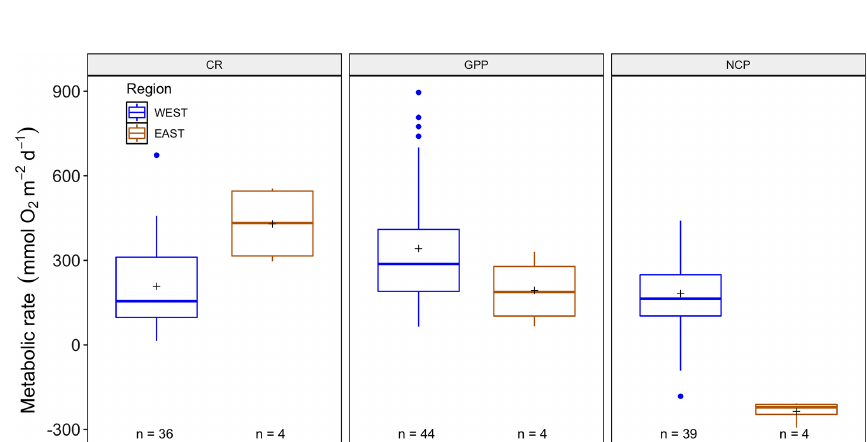
Figure 3. Averaged GPP, NCP and CR (mmolO 2 m − 2 d − 1 ) values for eastern (blue) and western (orange) Mediterranean basins calculated from measurements of multiparametric sensors. Upper and lower hinges correspond to the upper and lower quartiles; the lines inside the boxes correspond to the median; the mean is marked by a crosshair; and the error bars are based on minimum and maximum standard deviation for each parameter. We found differences with p < 0 . 05 for NCP between the